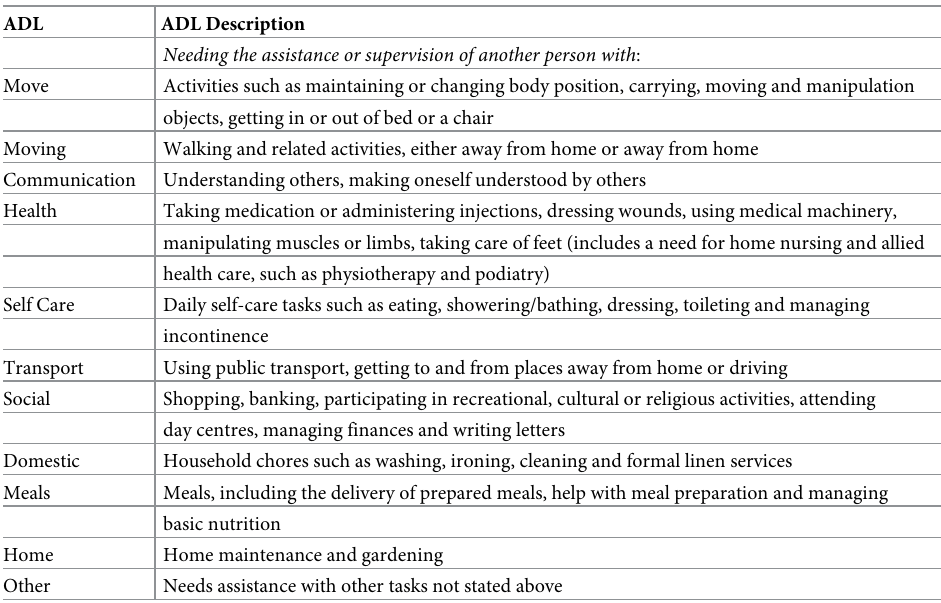
Table 2. ADL assistance needs